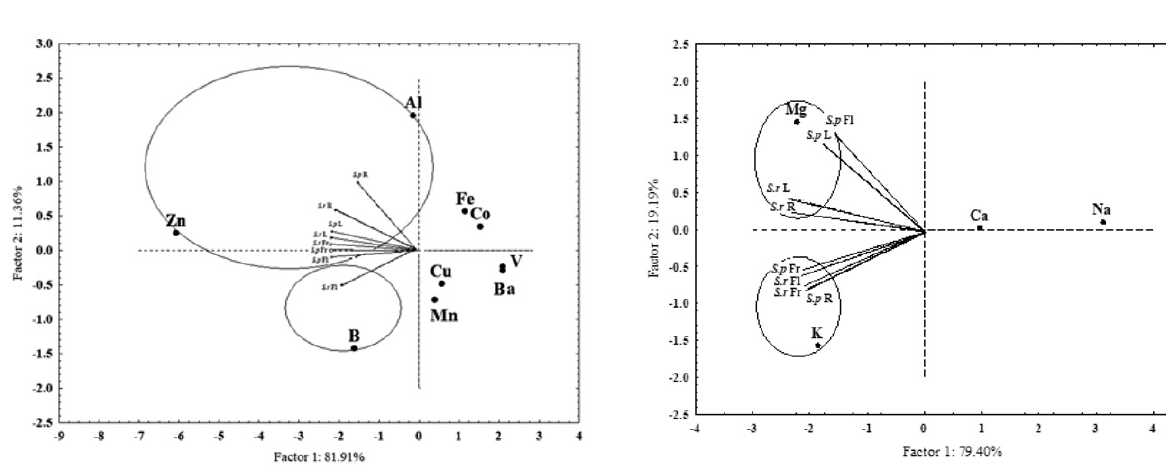
Figure 2. PCA diagram of the variables of the content of microele- ments (Al, B, Ba, V, Co, Fe, Cu, Mn, and Zn) in the leaf, flower, fruit, and root of plant species S. rigidum and S. pallasii